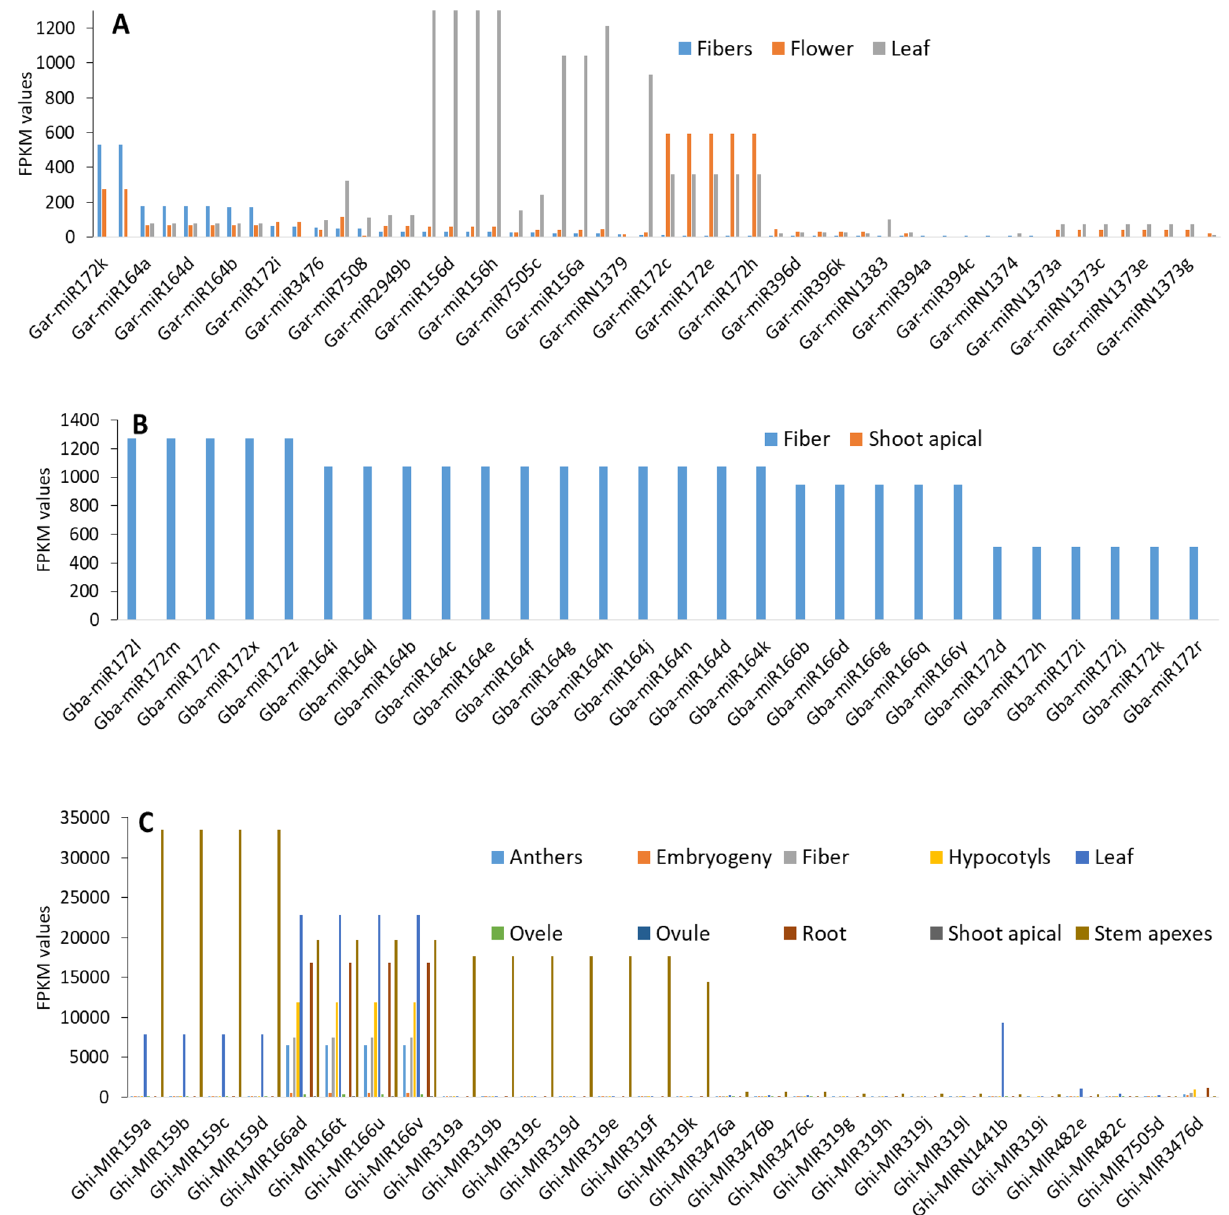
Figure 7. Identified miRNA family member’s expression profiling in different tissues. ( A ) G. arboreum, ( B ) G. barbadense , and ( C ) G.